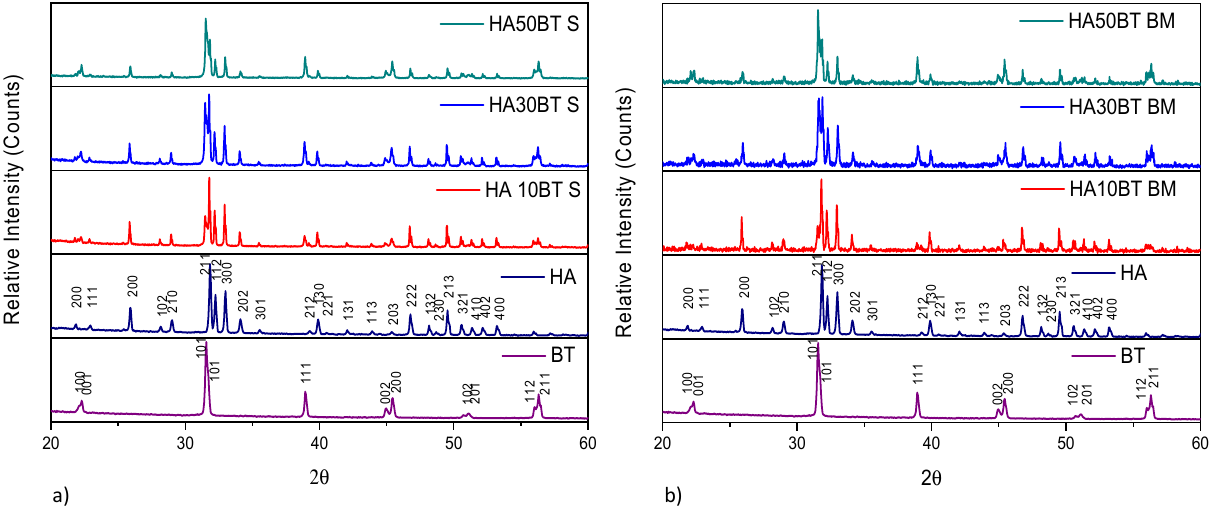
Figure 3. XRD patterns of primary powders vs different HA/BT samples: ( a ) powders homogenized by MSH (S), and ( b ) powders homogenized by HEBM (BM).